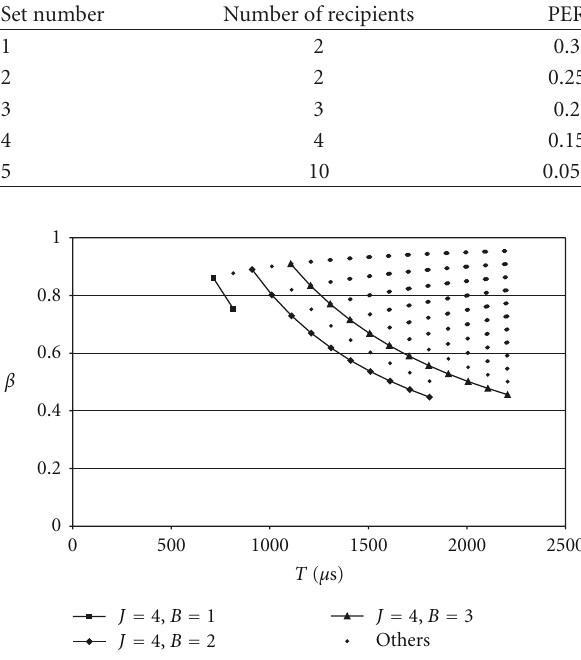
Figure 5: Consumed bandwidth fraction versus